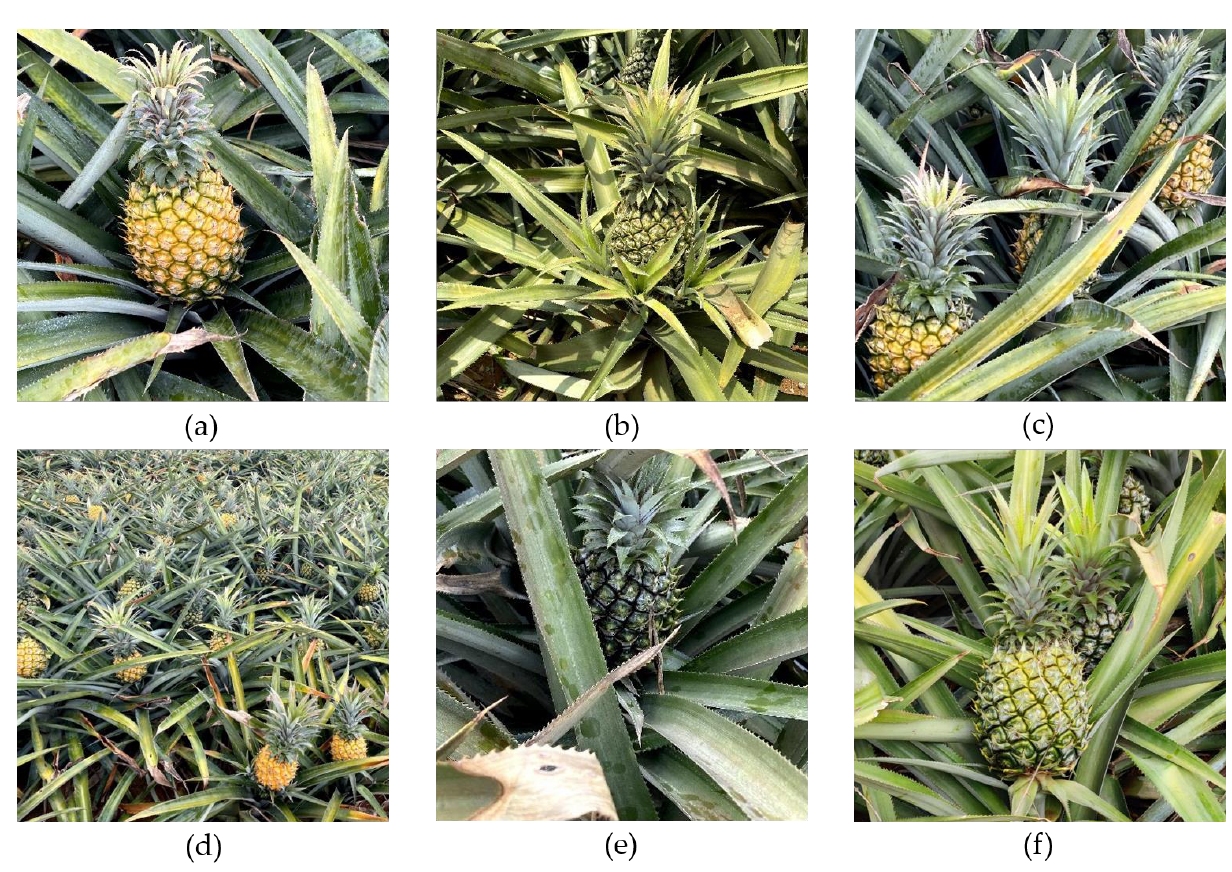
Figure 1. Image acquisition equipment.